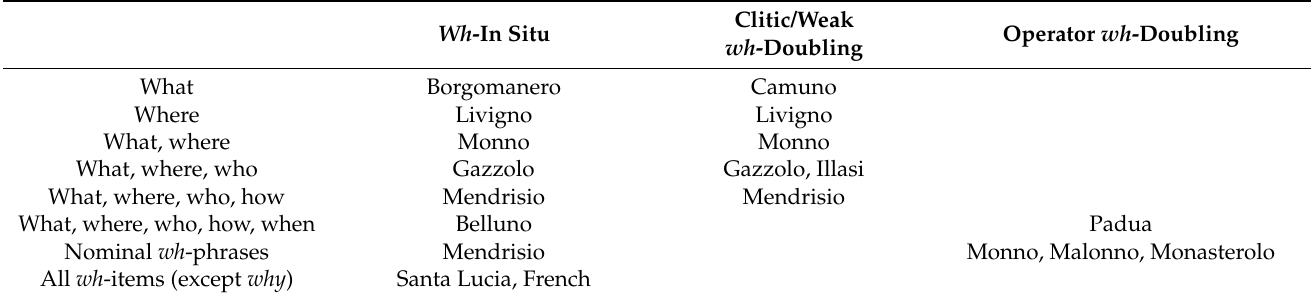
Table 1. Wh -in-situ and wh -doubling strategies in the